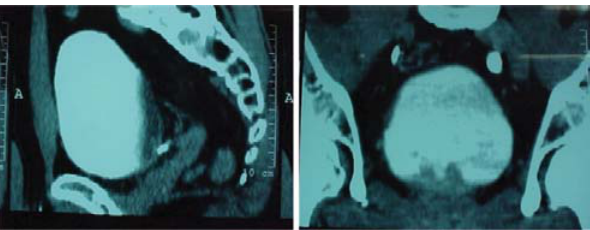
Figure 2 - Computed tomography indicating a mass between the bladder and the rectum, in a sagittal section, and at the base of the bladder in a frontal